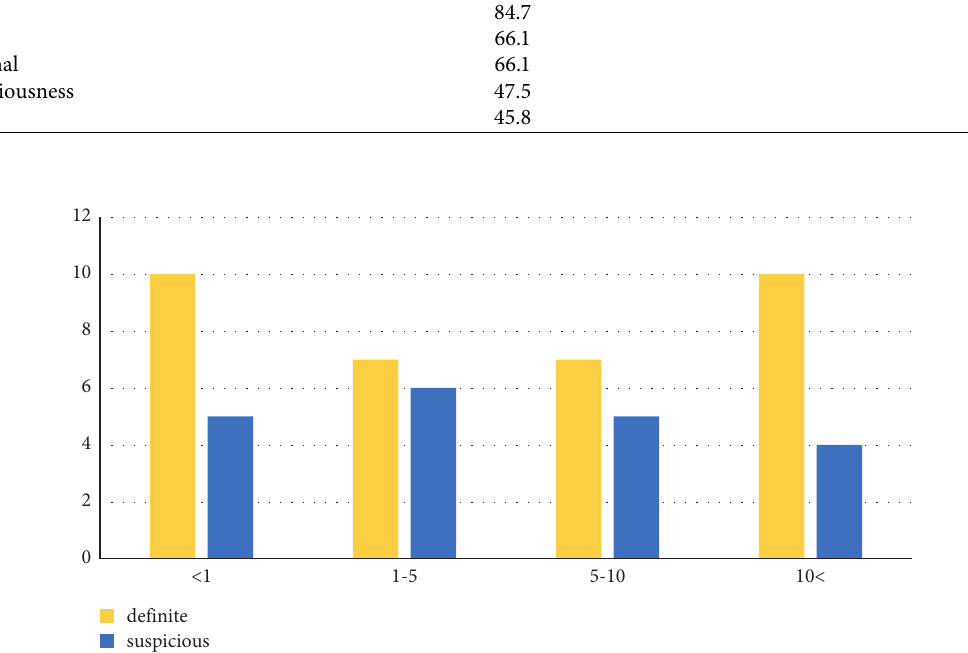
Figure 1: Age chart of the definite and suspicious groups.